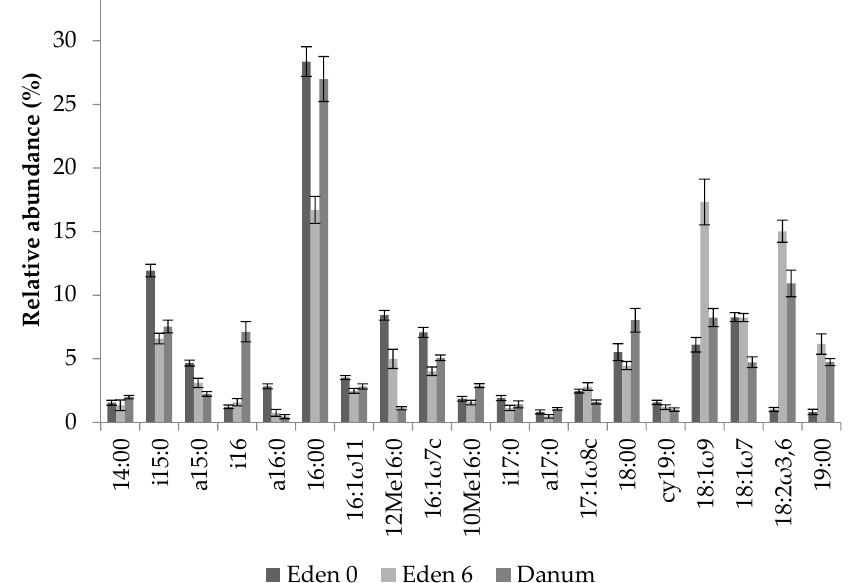
Figure 3. Relative abundance of fern soil PLFAs from experimental bird’s nest ferns at the Eden Project prior to suspension and after 6 months under epiphytic conditions, and from natural specimens from Danum Valley (all means ± s.e., n = 20).